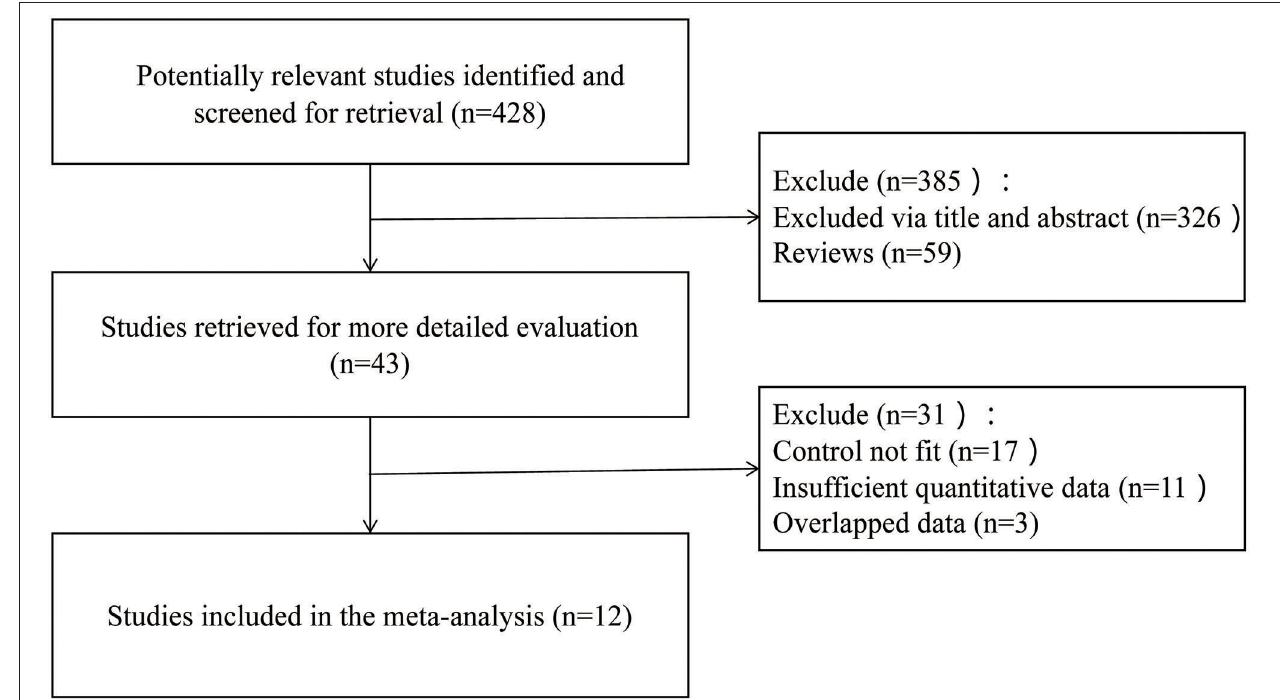
FIGURE 1 | Flow diagram of literature screening.